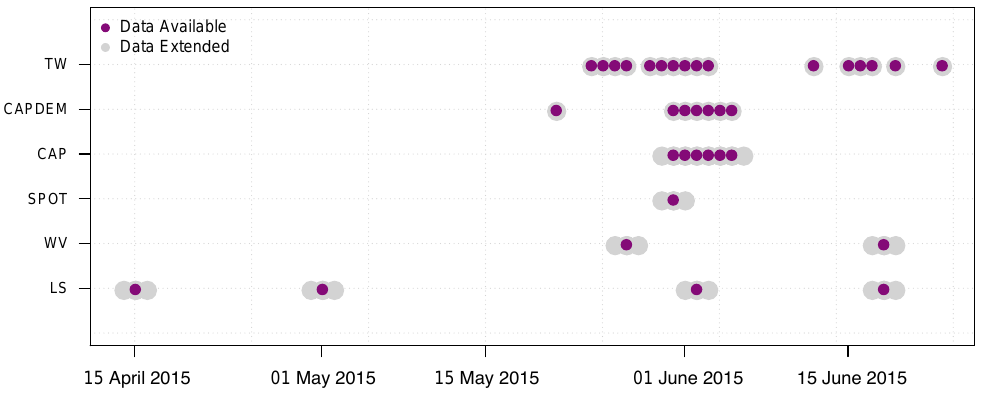
Figure 4. Diagram showing the temporal data extension after the data fusion method was applied. Purple dots represent the original day of data acquisition. The light gray dots represent the days added after data are extended via